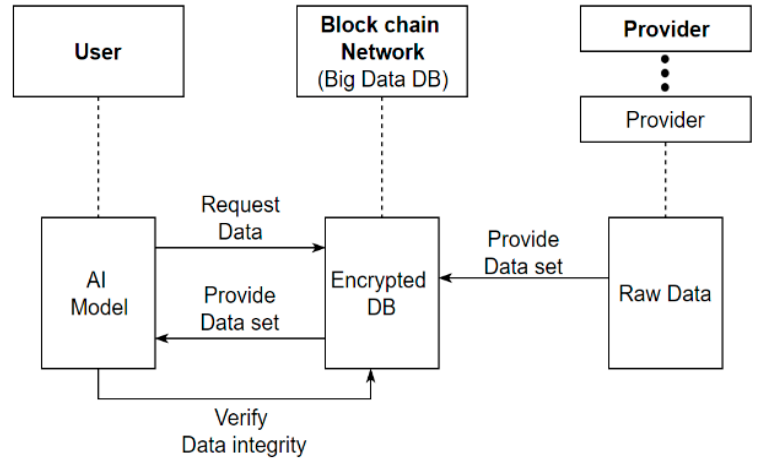
Figure 2. Blockchain-based AI learning data open network.